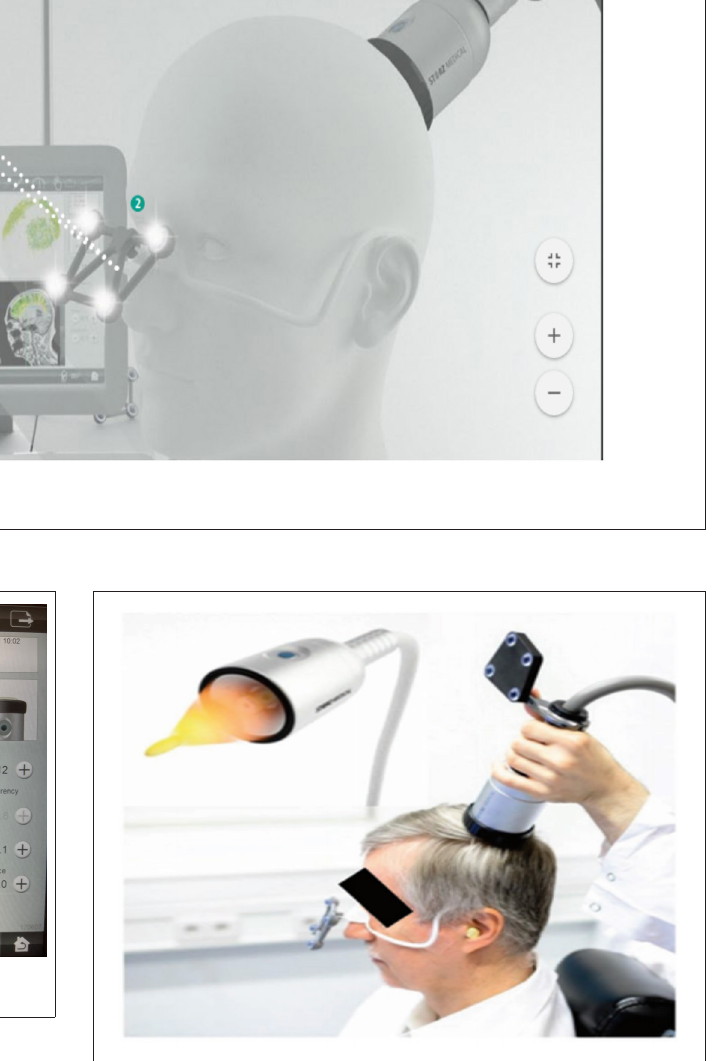
FIGURE 3 | Patient is having a TPS